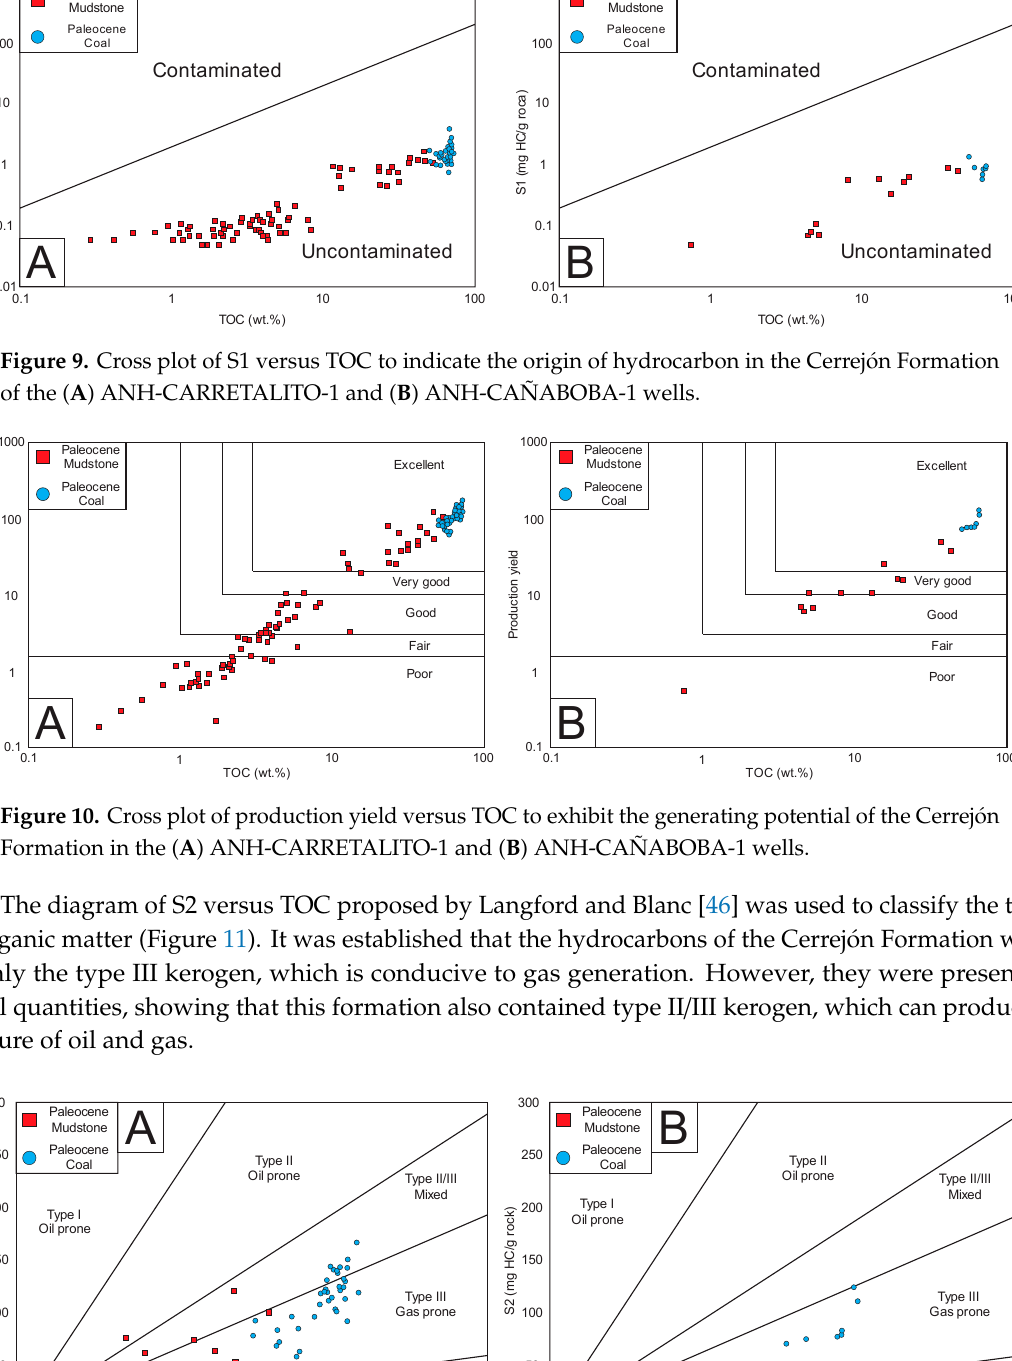
Figure 9. Cross plot of S1 versus TOC to indicate the origin of hydrocarbon in the Cerrejón Formation of the ( A ) ANH-CARRETALITO-1 and ( B ) ANH-CAÑABOBA-1 wells.